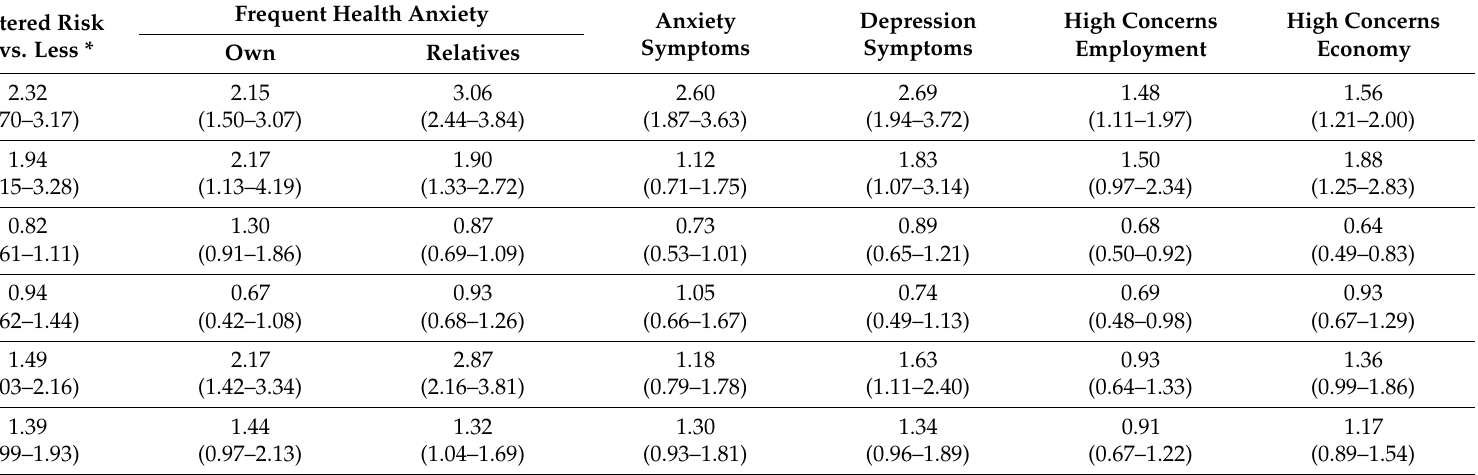
Depression High Concerns High Concerns Symptoms Symptoms Employment